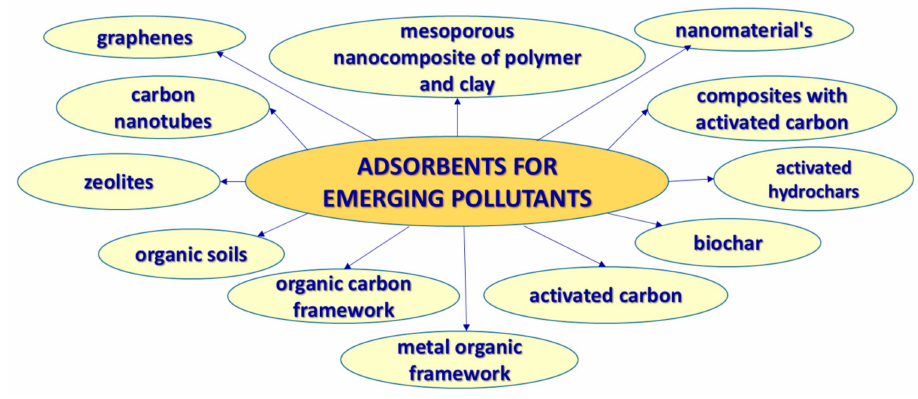
Figure 9. Various categories of adsorbents used in the elimination of emerging